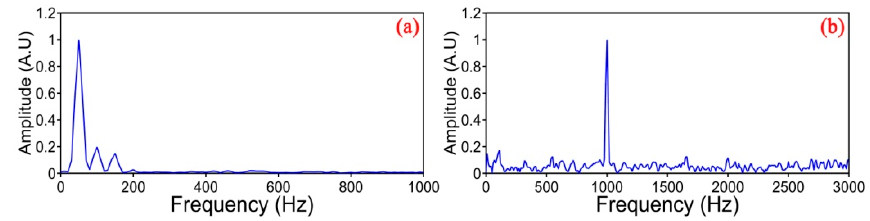
Figure 7. Frequency information for the vibration events. ( a ) For 50 Hz; ( b ) For 1 KHz.